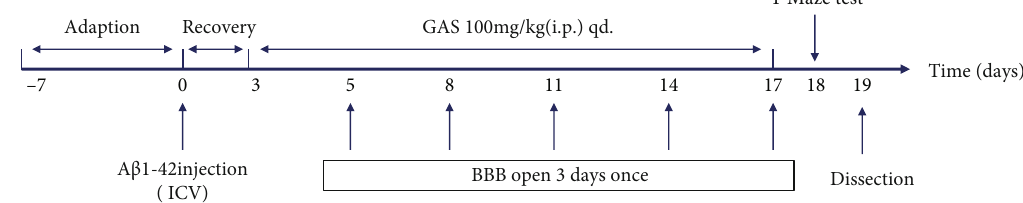
Figure 1: Timeline of the experimental